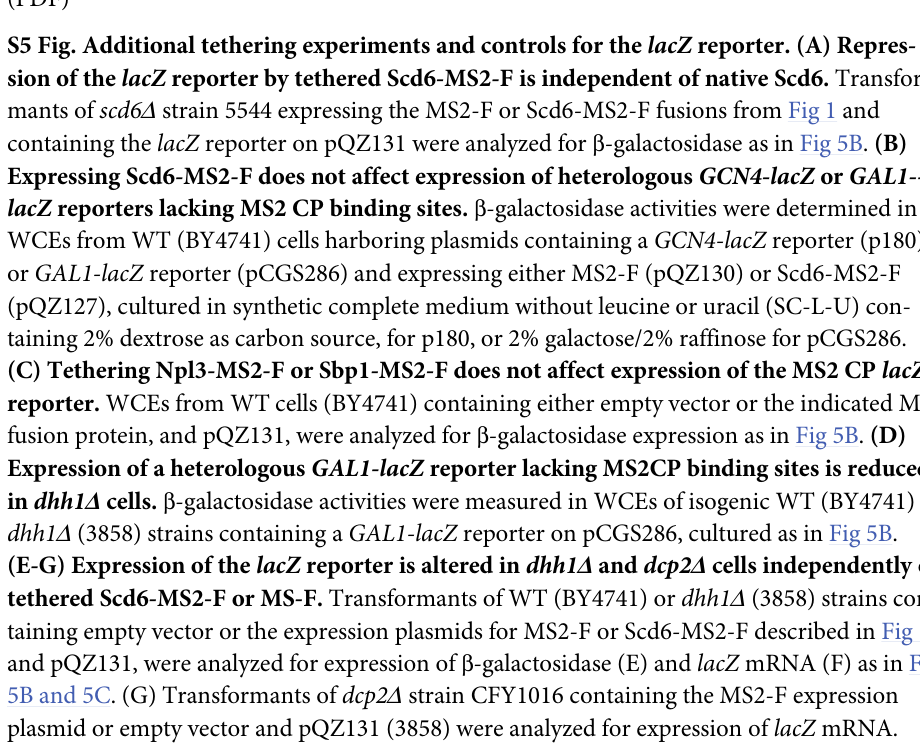
S2 Fig. Tethering Npl3-MS2-F or Sbp1-MS2-F does not reduce GFP reporter protein expression in vivo . (A-B) WT cells (BY4741) transformed with plasmids expressing MS2 - NPL3 F (pQZ128) or Npl3-MS2-F (pQZ125) and GFP reporter plasmid pJC429 were analyzed for GFP protein expression as in Fig 1B and 1C. Average results ( ± S.E.M.s) from at least three bio- logical replicates are represented. (C-D) WT cells (BY4741) were co-transformed with plas- mids encoding MS2 -F (pQZ129) or Sbp1-MS2-F (pQZ126) and pJC429 were analyzed for SBP1 GFP protein expression as in Fig 1B and 1C. Mean values ( ± S.E.M.s) were determined from at least three biological replicates. ( E ) WCEs of WT cells transformed with plasmids expressing the indicated MS2 fusion proteins were subjected to Western blot analysis using antibodies against FLAG (upper) or Prt1 (lower). (PDF) S3 Fig. Control experiment showing that tethering MS2-F does not reduce GFP reporter protein expression in dcp2 Δ cells. Transformants of dcp2 Δ strain CFY1016 harboring expres- sion plasmids for MS2-F (pQZ130) or empty vector YCplac111 and GFP reporter pJC429, were analyzed for GFP protein expression as in Fig 1B–1D. (PDF) S4 Fig. Polysome size distribution of GFP reporter mRNA is altered on tethering Scd6-MS2-F. (A-B) Results from three biological replicate gradients of dcp2 Δ transformants harboring the GFP reporter and expressing MS2-F (A) or Scd6-MS2-F (B), which were aver- aged to produce the results shown in Fig 3B. WCEs were separated by velocity sedimentation on sucrose density gradients and fractionated with continuous monitoring at A . The abun- 254 dance of GFP mRNA was quantitated by RT-qPCR in total RNA extracted from the gradient fractions and plotted as the percentage of total signal in the gradient. (PDF) S5 Fig. Additional tethering experiments and controls for the lacZ reporter. (A) Repres- sion of the lacZ reporter by tethered Scd6-MS2-F is independent of native Scd6. Transfor- mants of scd6 Δ strain 5544 expressing the MS2-F or Scd6-MS2-F fusions from Fig 1 and containing the lacZ reporter on pQZ131 were analyzed for β -galactosidase as in Fig 5B. (B) Expressing Scd6-MS2-F does not affect expression of heterologous GCN4-lacZ or GAL1-- lacZ reporters lacking MS2 CP binding sites. β -galactosidase activities were determined in WCEs from WT (BY4741) cells harboring plasmids containing a GCN4-lacZ reporter (p180) or GAL1-lacZ reporter (pCGS286) and expressing either MS2-F (pQZ130) or Scd6-MS2-F (pQZ127), cultured in synthetic complete medium without leucine or uracil (SC-L-U) con- taining 2% dextrose as carbon source, for p180, or 2% galactose/2% raffinose for pCGS286. (C) Tethering Npl3-MS2-F or Sbp1-MS2-F does not affect expression of the MS2 CP lacZ reporter. WCEs from WT cells (BY4741) containing either empty vector or the indicated MS2 fusion protein, and pQZ131, were analyzed for β -galactosidase expression as in Fig 5B. (D) Expression of a heterologous GAL1-lacZ reporter lacking MS2CP binding sites is reduced in dhh1 Δ cells. β -galactosidase activities were measured in WCEs of isogenic WT (BY4741) or dhh1 Δ (3858) strains containing a GAL1-lacZ reporter on pCGS286, cultured as in Fig 5B. (E-G) Expression of the lacZ reporter is altered in dhh1 Δ and dcp2 Δ cells independently of tethered Scd6-MS2-F or MS-F. Transformants of WT (BY4741) or dhh1 Δ (3858) strains con- taining empty vector or the expression plasmids for MS2-F or Scd6-MS2-F described in Fig 1, and pQZ131, were analyzed for expression of β -galactosidase (E) and lacZ mRNA (F) as in Fig 5B and 5C. (G) Transformants of dcp2 Δ strain CFY1016 containing the MS2-F expression plasmid or empty vector and pQZ131 (3858) were analyzed for expression of lacZ